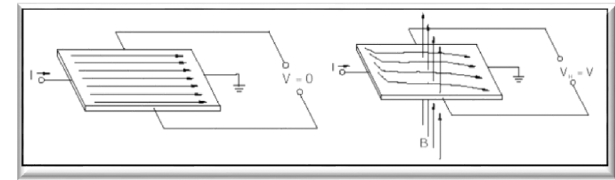
Fig. 3. Hall effect principle.